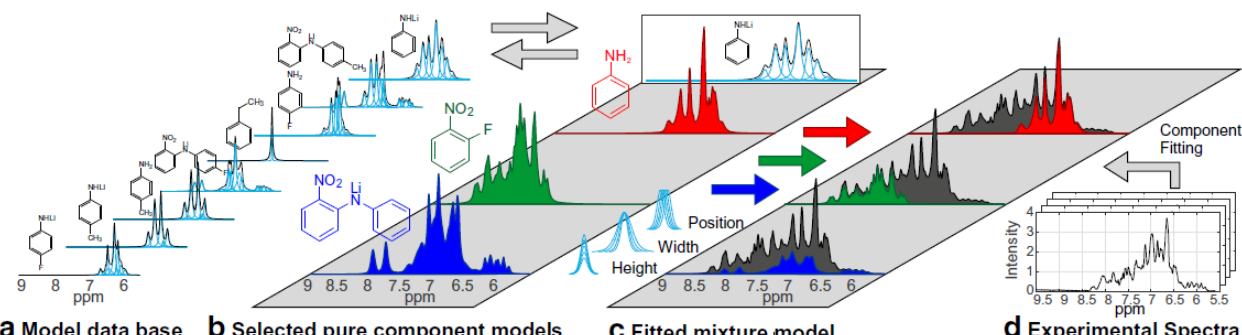
Figure 7. Indirect hard modeling workflow. Measured NMR spectra ( d ) are fitted by building a mixture model ( c ). The relevant pure component models ( b ) for each process can be selected from a pure component model database ( a ). Adapted with permission from [76], Springer, 2019.